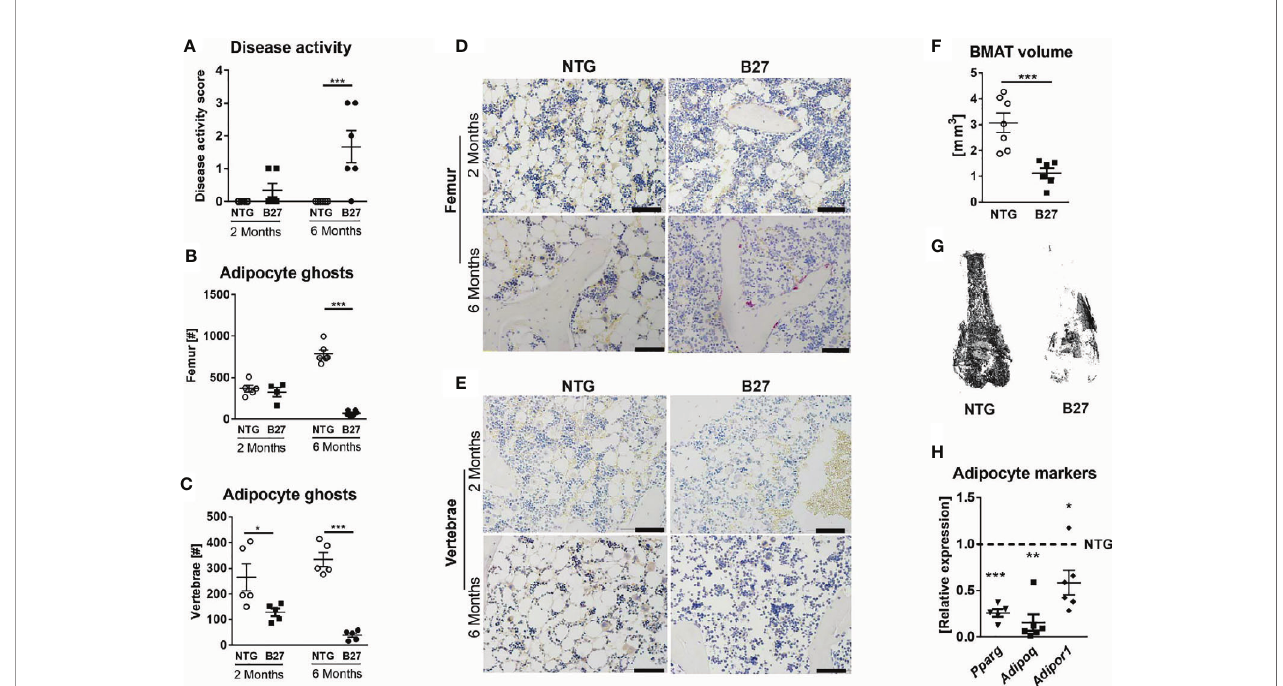
FIGURE 1 | Decreased numbers of bone marrow adipocytes in B27 transgenic rats. (A) Clinical score of 2 and 6 months old NTG and B27 rats. Disease level was graded from 0-3: 0=no in fl ammation, 1=arthritis on one leg, 2=arthritis on both legs, 3=severe arthritis, and other organ manifestation. (B) Number of bone marrow adipocytes ghosts from the femur of 2- and 6 months old NTG and B27 (n=5-6 per group). (C) Number of bone marrow adipocytes ghosts from the vertebrae of 2- and 6 months old NTG and B27 (n=5 per group). (D, E) Representative histology sections from femur and vertebrae of 2-and 6 months old NTG and B27 rats stained with von Kossa/toluidine blue (scale bar: 100 μm) (F, G) Osmium tetroxide staining for bone marrow adipose tissue (BMAT) followed by micro-computed tomography ( m CT) analysis. Quanti fi cation of fat volume (F) and representative images (G) of stained lipids in femora of NTG and B27 rats (n=6-7 per group). (H) Relative expression of PPAR g , adiponectin, and adiponectin receptor in the bone marrow of NTG and B27 rats. Results are presented as individual dots with the mean indicated as horizontal line (n=5-6 per group). *p < 0.05; **p < 0.01 and ***p ≤ 0.001 vs. controls via unpaired Student ’ s